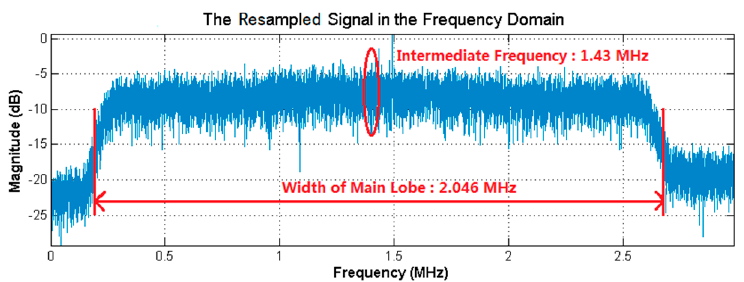
Figure 7. The resampled signal by applying the resampling strategy to the main lobe signal of Dataset 1 in the frequency domain. The bandwidth of the resampled signal is 2.046 MHz , the intermediate frequency is 1.43 MHz and the sampling frequency is 5.97 MHz .